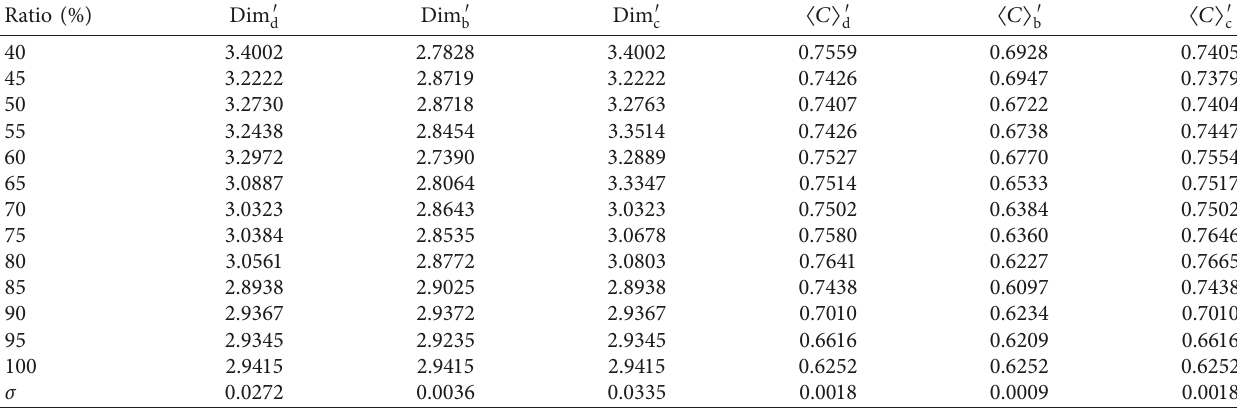
Table 5: Changes of box dimension and cluster coefficient of USAir network with nodes removal by ascending order.